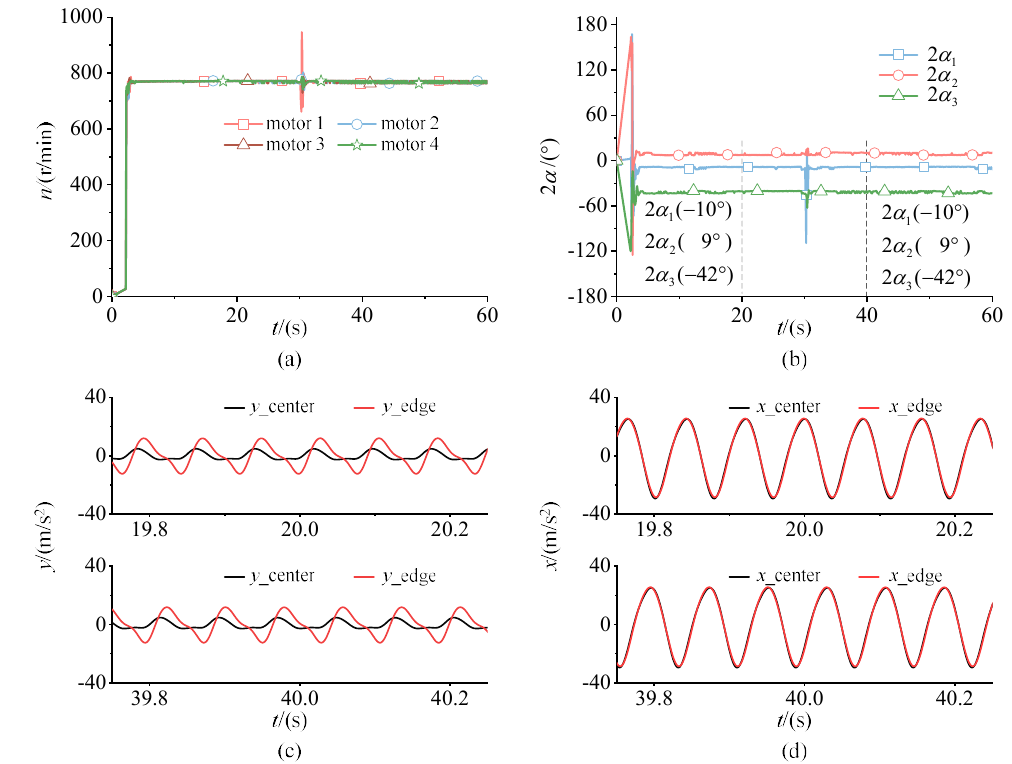
Figure 5. Phase differences of ERs change from 0 ◦ to 0 ◦ with disturbance: ( a ) Synchronous veloc- ities of four ERs; ( b ) Phase differences; ( c ) Acceleration amplitude in y direction at 20 s and 40 s; ( d ) Acceleration amplitude in x direction at 20 s and 40 s.